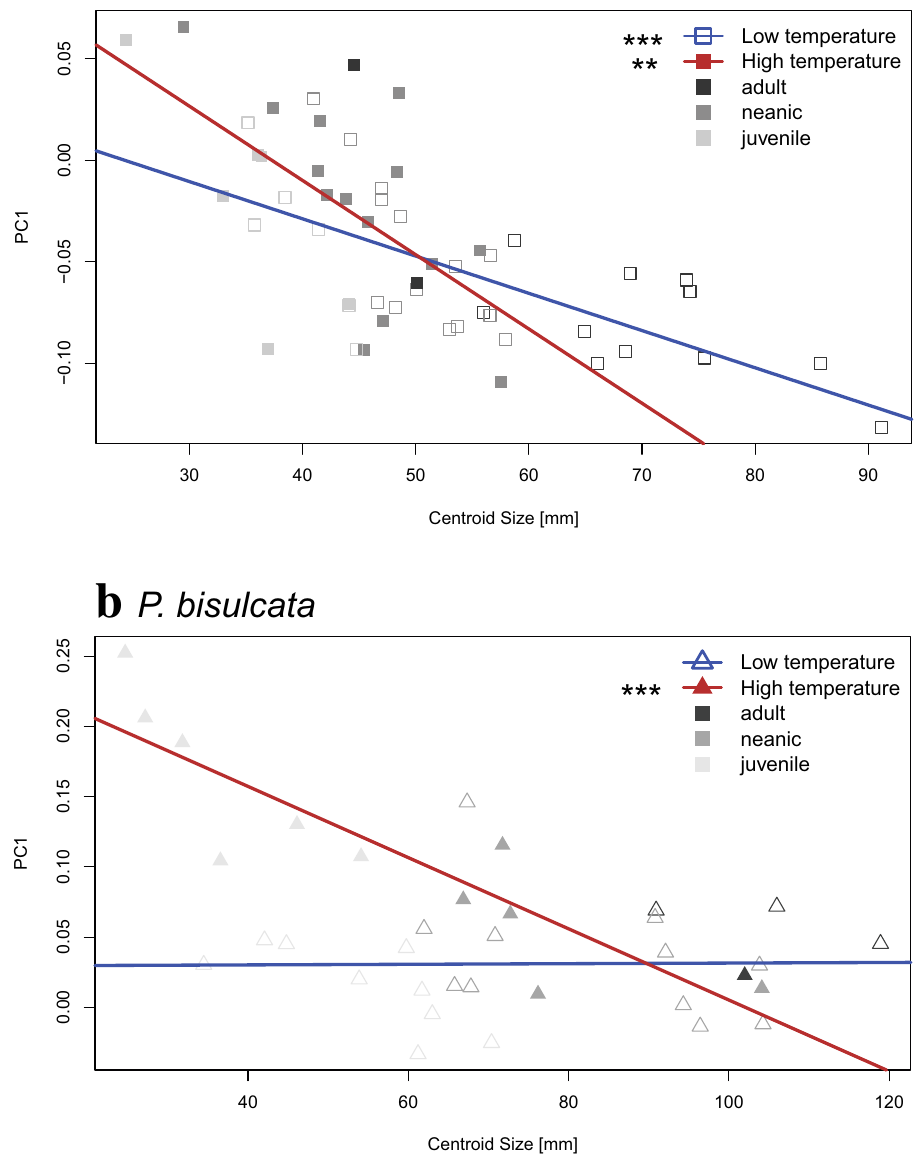
Figure 3. Linear regression lines of GPA Centroid Size with PC1 for cooler (blue line; empty points) and warmer (red line; filled points) times in C. longiforma ( a ) and P. bisulcata ( b ). The shade of the points indicates ontogenetic stage (light grey: juvenile, medium grey: neanic, black: adult). Significance levels of the regressions are indicated next to the